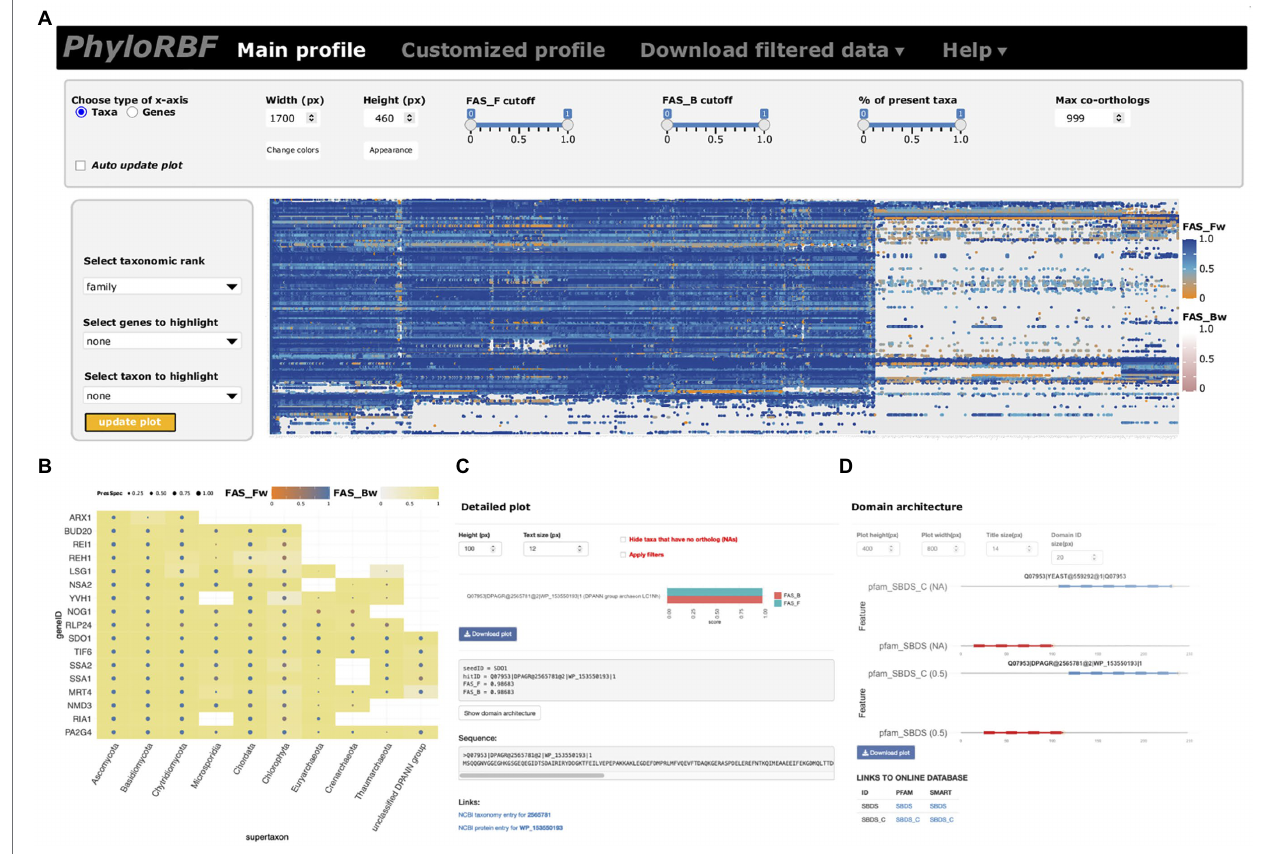
assigned to evolutionarily younger phylostrata increases with filtering strength, and even the two positive controls were